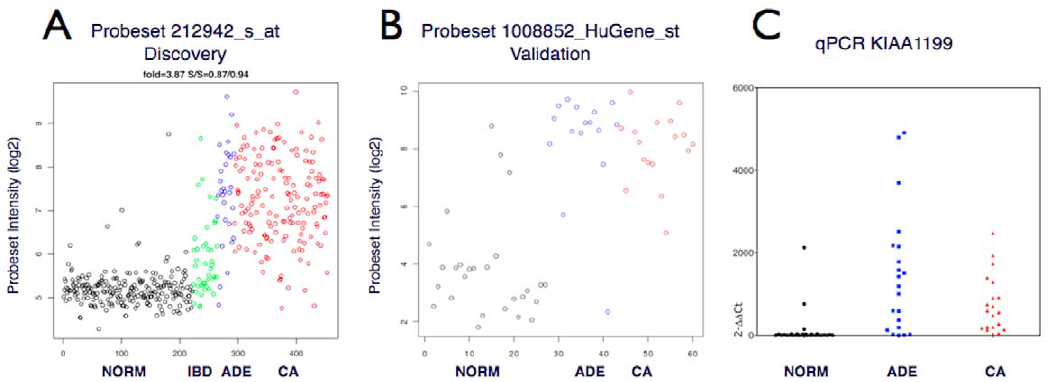
Figure 3. KIAA1199 expression in colon tissue specimens. ( A ) KIAA1199 expression measured via probeset 212942_s_at in the discovery dataset of 454 colorectal tissue specimens (x-axis indexed by phenotype); Norm: 222 normal specimens, black; IBD: 42 ‘colitis’ specimens, green; ADE: 29 adenomas, blue; CA: 161 cancer specimens, red. Y-axis: normalized probeset intensity (log2). ( B ) KIAA1199 expression measured via probeset 1008852-HuGene_st in the validation dataset in 68 colorectal tissue specimens. X-axis; Norm: 30 normal colon tissue specimens, black; ADE: 19 adenomas, blue; CA: 19 colorectal cancer specimens, red. Y-axis: normalized probeset intensity (log2). ( C ) A quantitative real-time SYBR-green KIAA1199 PCR assay applied to RNA extracts used for the validation microarray data: 30 normal, black; 21 adenomas, blue; 20 colorectal cancer, red specimens. Data are mean values of duplicates, normalized against HPRT1 and depicted as delta-delta-Ct values. Note that three additional neoplastic specimens were available for the PCR experiments which were not tested by custom microarray.